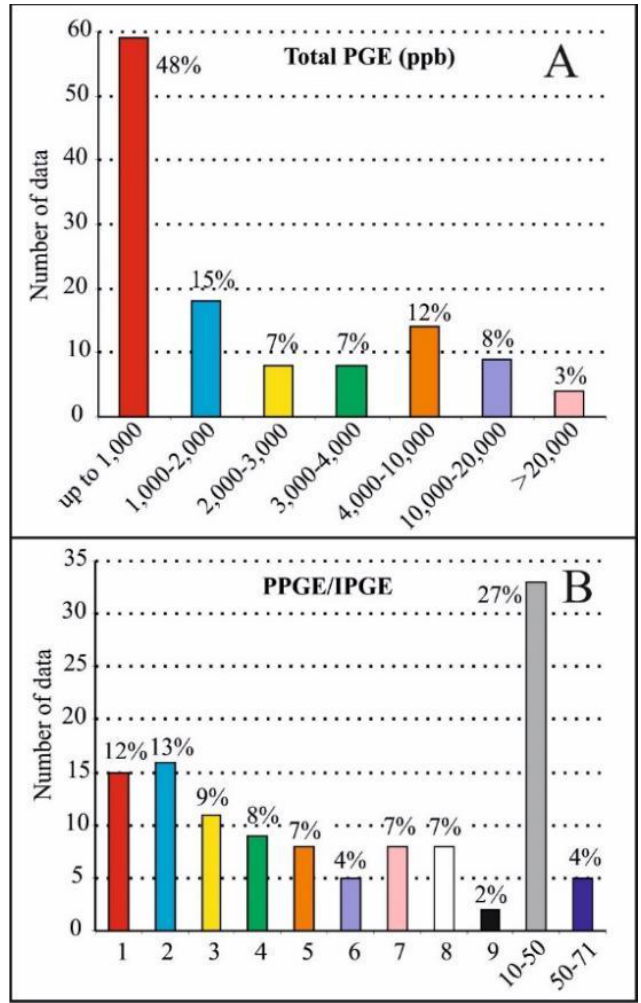
Figure 2. Statistical distribution of the PGE in the overviewed chromitites. ( A ) Total PGE abundance, ( B ) frequency of the values of the PPGE/IPGE ratio.